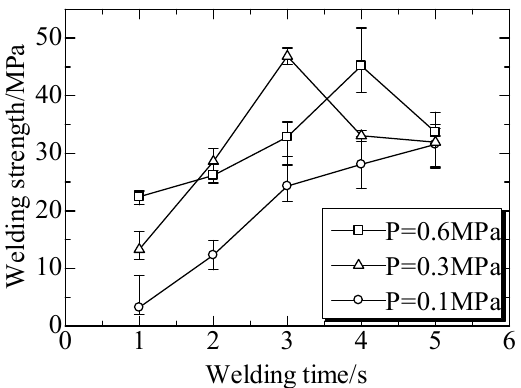
Figure 21. Welded strengths at different welding times under different welding pressures ( P ). Adapted from Reference [151].